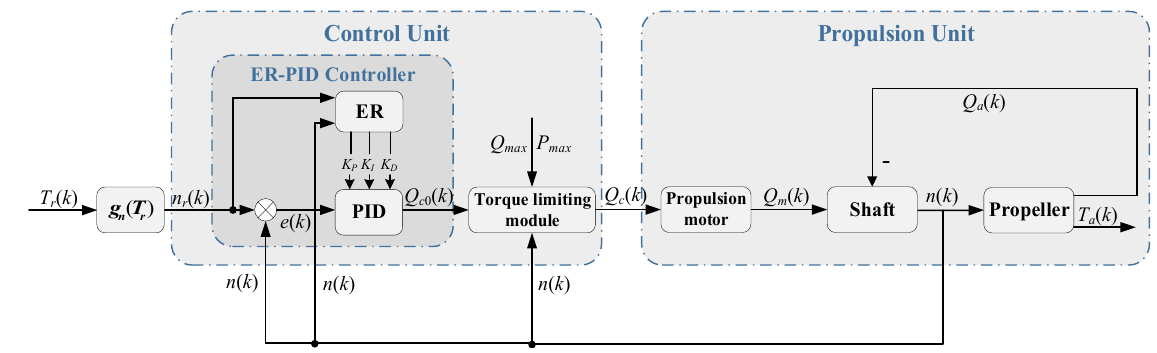
Figure 3. Block diagram of the shaft speed control model.